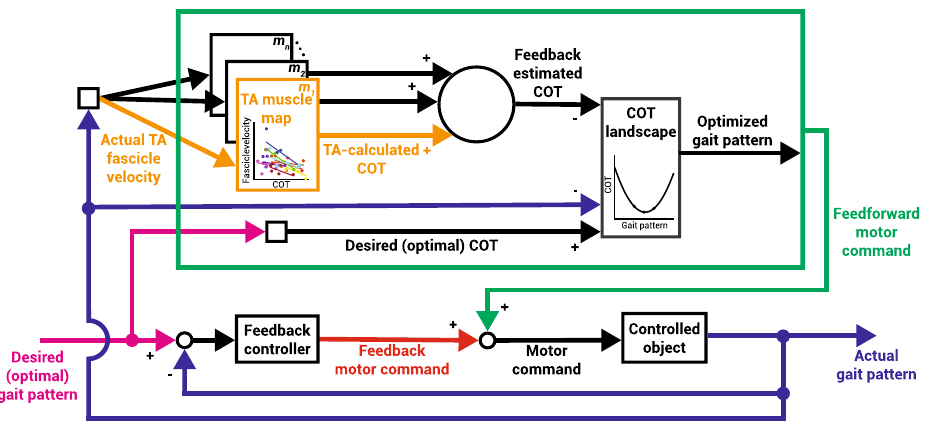
Figure 5. Proposed feedback control model of gait using cost of transport (adapted from Wolpert et al. 54 ). The controlled object, which is a physical entity controlled by the central nervous system such as the legs, consists of transformations from motor command to the motion of the controlled object resulting in a gait pattern. “Optimal” can be considered the gait pattern that minimizes the COT. The actual gait pattern manifests itself through the lengthening and shortening of a subset of n muscles. Each respective muscle map m n correlates individual muscle feedback and whole-body COT, such as TA muscle fascicle velocity as derived from our study (orange, Fig. 3). The individual muscle estimates can be summed to create a more accurate representation of whole-body COT. This feedback-estimated COT value along with the actual gait pattern provides a state estimation within the COT landscape (Fig. 1). An error-based correction can then be made to ultimately generate a predicted optimized gait pattern as a feedforward motor